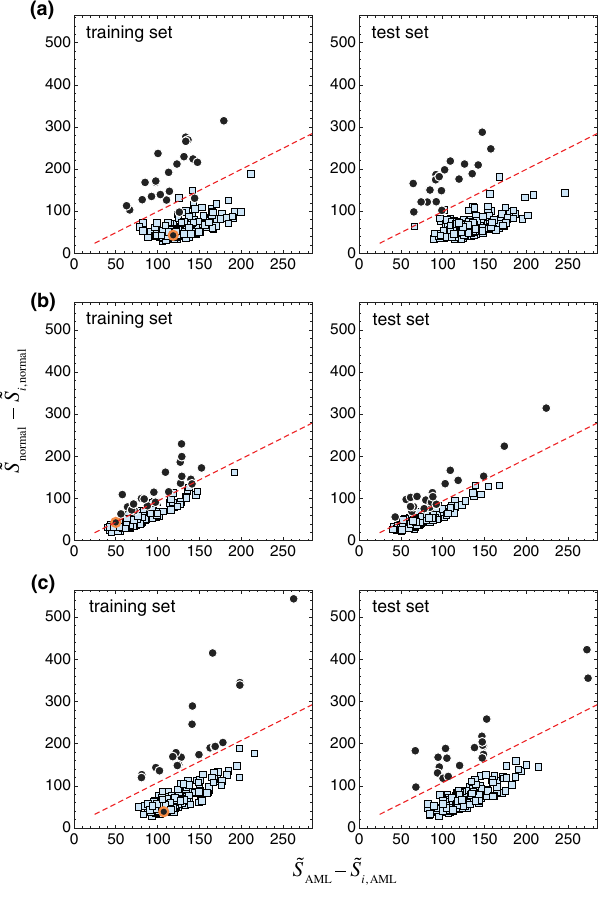
FIG. 3. Total and weighted entropies on the two-dimensional landscapes defined by the maximum-entropy distribution for AML and normal states. The entropies for the training (left-hand column) and test (right-hand column) sets were computed from Eq. (5) with uniform w k (a), with the w k that maximize the ~ S distance ΔΔ of the training set (b), and with the w k that ~ S maximize the distance ΔΔ of the training set excluding patient no. 116 (c). Circles and squares represent, respectively, the actual AML and normal state of a patient as clinically assessed by a ~ S − ~ S physician. The dashed lines are given by i; normal ¼ normal ~ S − ~ S ΔΔ ~ S ð t = 2 with the value of ΔΔ ~ S ð t = 2 i; AML þ AML max Þ max Þ equal to 0 (a), − 5 . 21 (b), and 8.15 (c). The black circle with the orange contour corresponds to AML patient no.